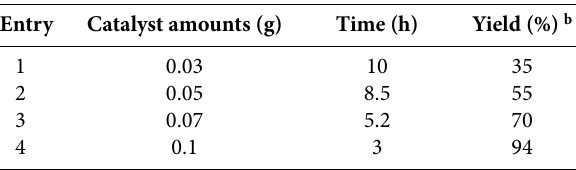
Table 1. Effect of the catalyst amount on the reduction of 4-chloroni- trobenzene. a Entry Catalyst amounts (g)